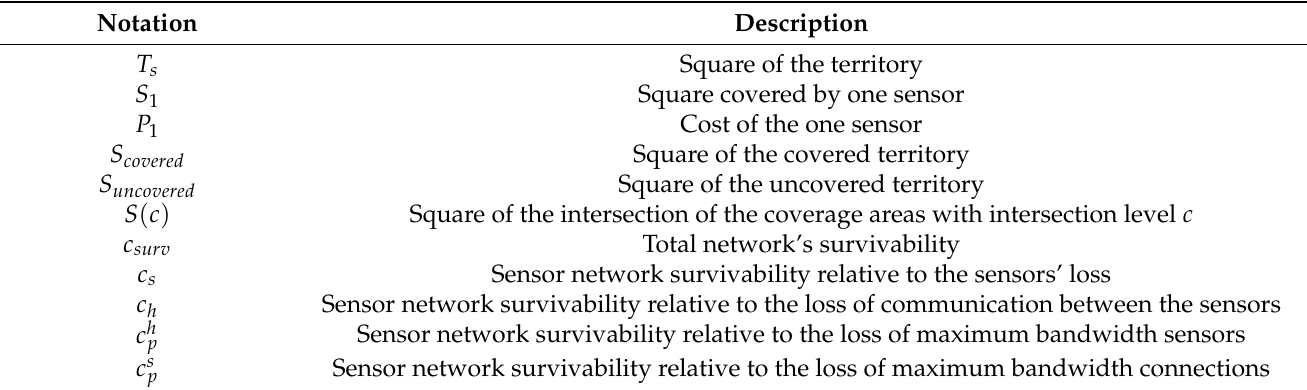
Table 2. Notation used in this